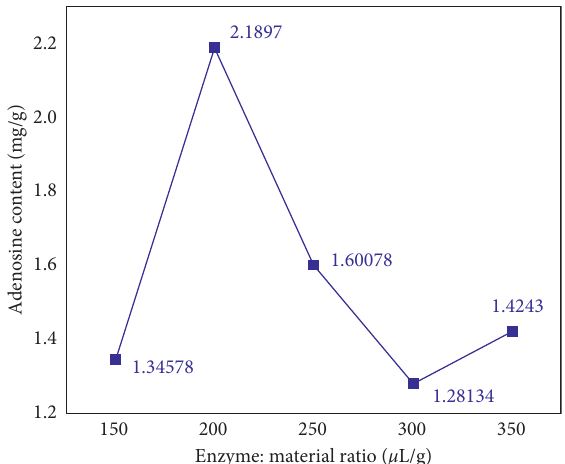
Figure 4: Effect of enzyme-to-material ratio on the adenosine content.